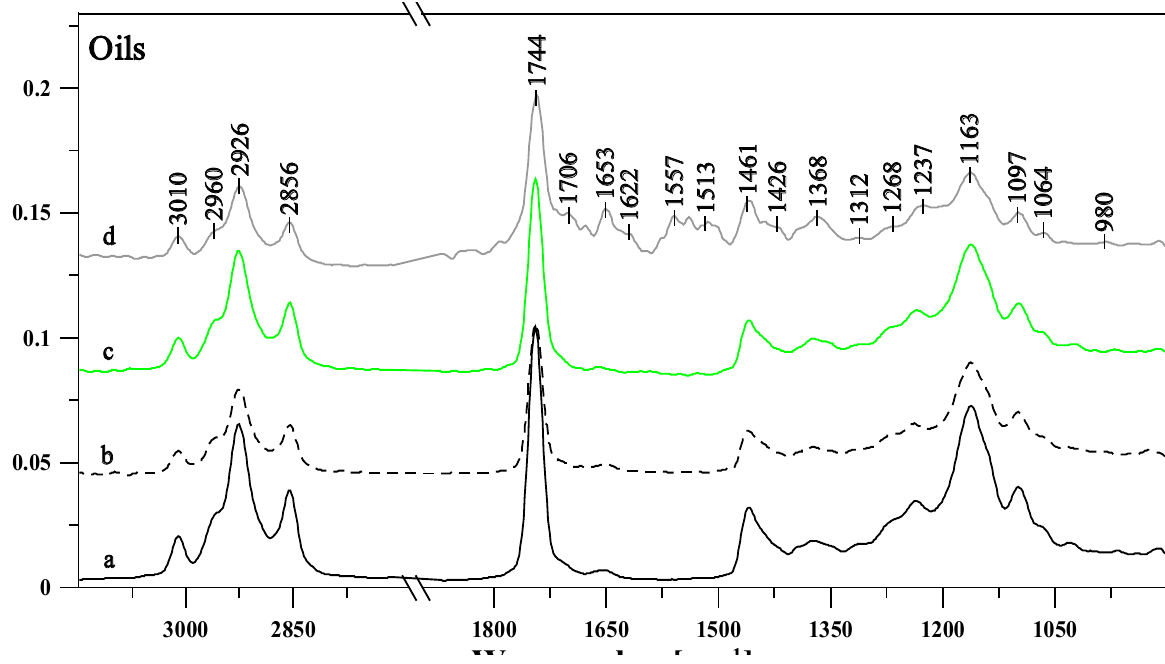
Figure 1 : ATR-FTIR spectra for selected Moldavian dragonhead oil samples stored at 7 o C (refrigerated): a – immediately after pressing, b – two weeks after pressing, c – four weeks after pressing, d – 8 weeks after pressing.